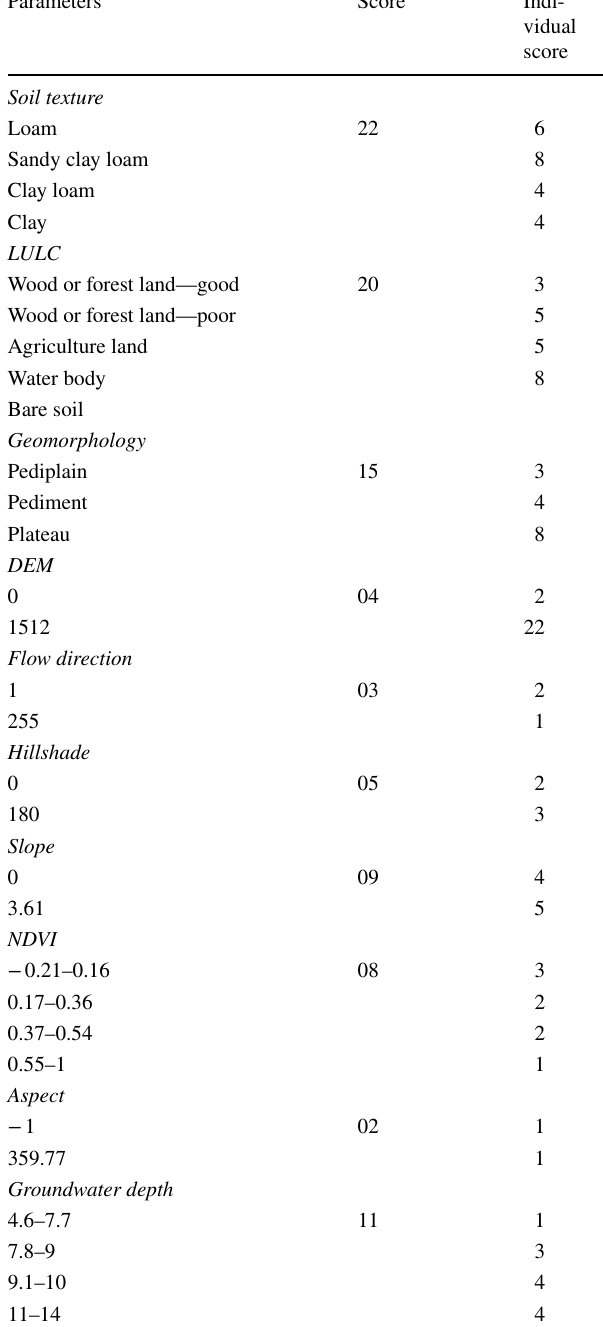
Table 8 Classification of weighted parameters influencing the GWPZ